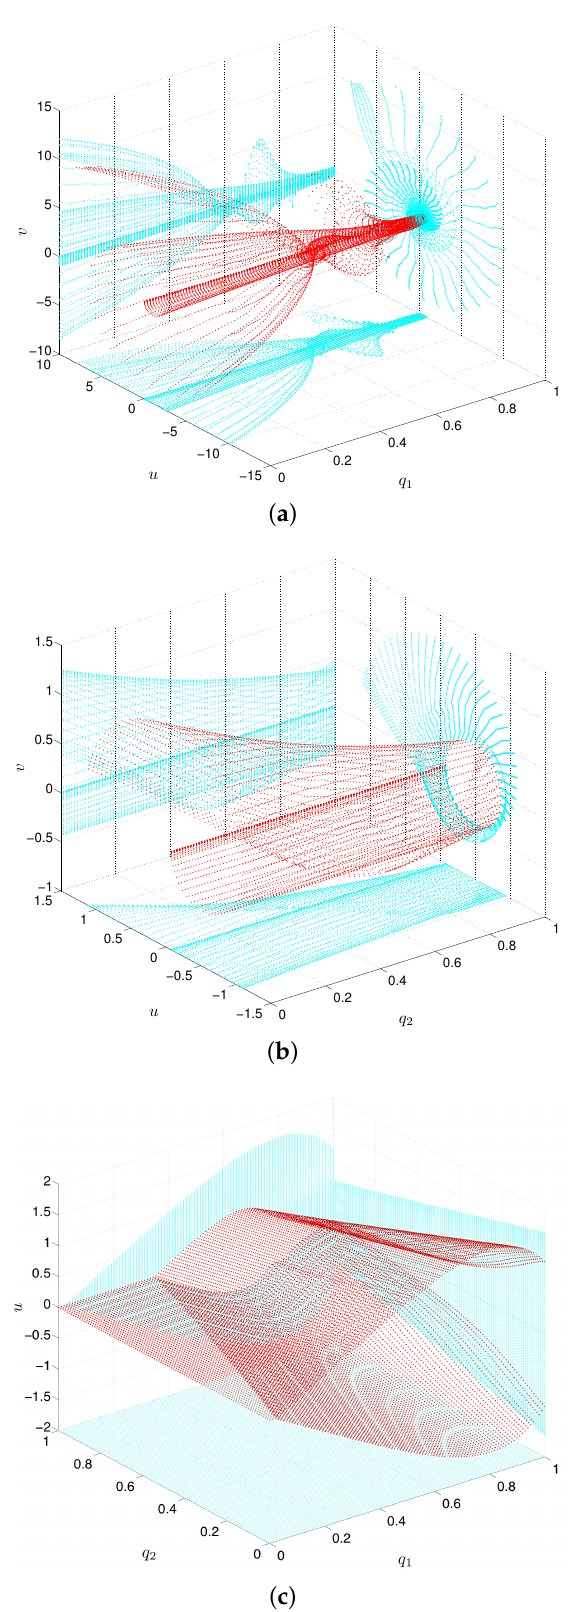
Figure 8. ( a – c ) Bifurcation diagrams of radiation factor of the i th ( i = 1,2) primary in the frames q 1 uv , q 2 uv and q 1 q 2 u , respectively, when κ = 1, µ m = 0.48785, α 1 = 0.024, α 2 = 0.02, α = 1.001, β =